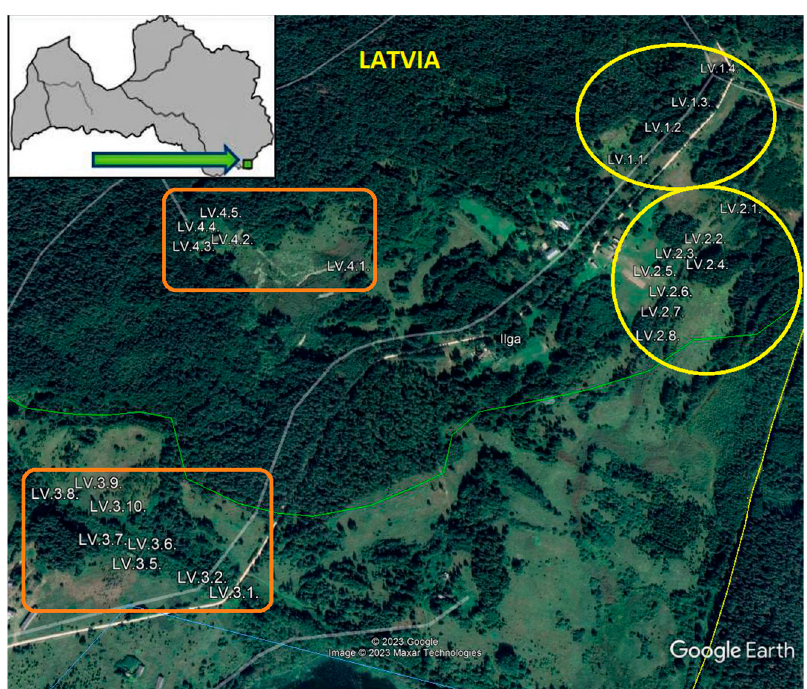
Figure 1. A map of the location of ponds in the Silene Nature Park, South East of Latvia: yellow ovals—geographically isolated wetlands (GIW) (isolated ponds); orange rectangles—non-isolated ponds (nGIW) (the green arrow indicates the location of the study